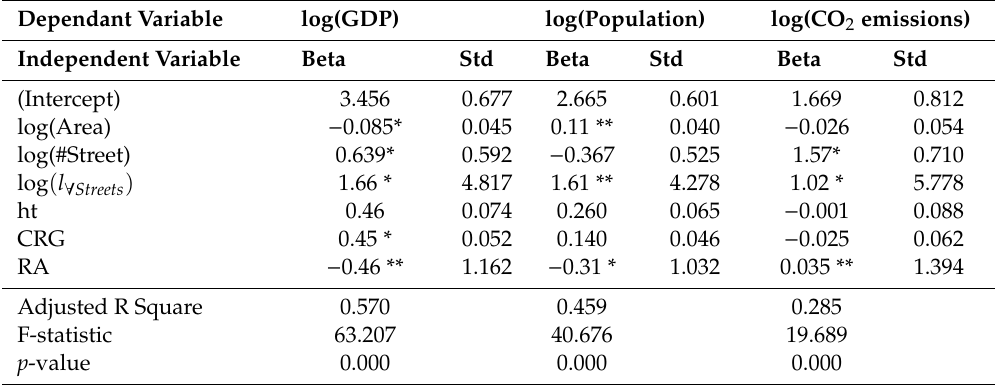
Table 5. Multiple regression results between fractal metrics and urban